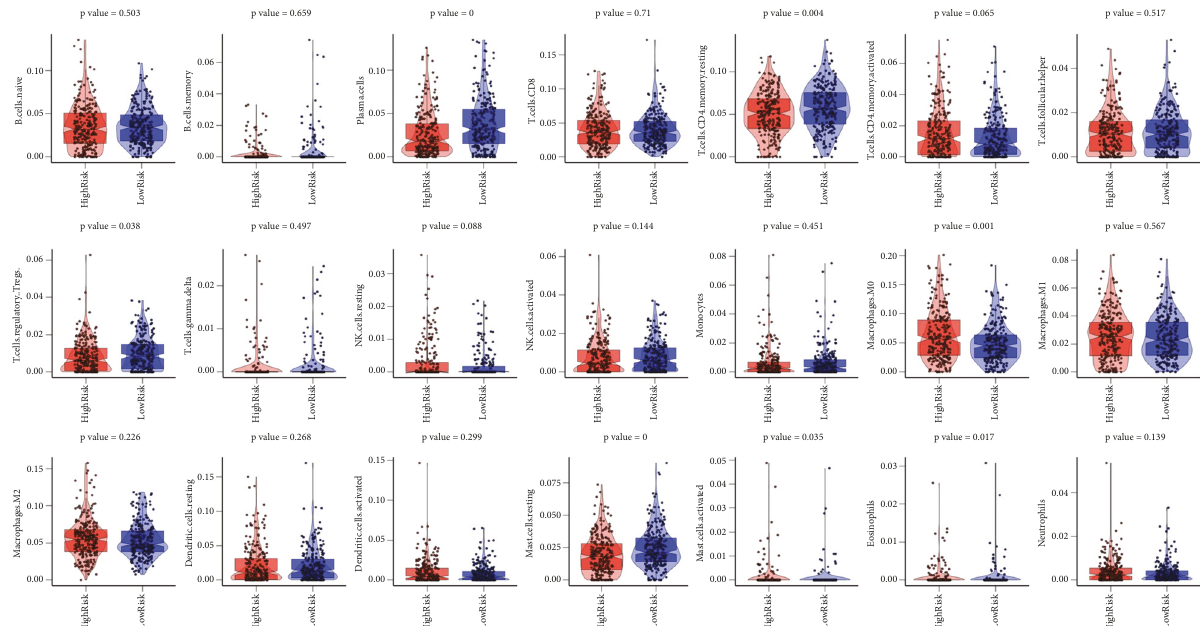
Figure 8: After risk scoring with a prognostic model, the high-risk and low-risk groups were defined using the median. CIBERSORT was utilized to estimate immune cell infiltration levels and comparison of cell infiltration levels in the high-risk and low-risk groups. p value was calculated using the Mann–Whitney test.